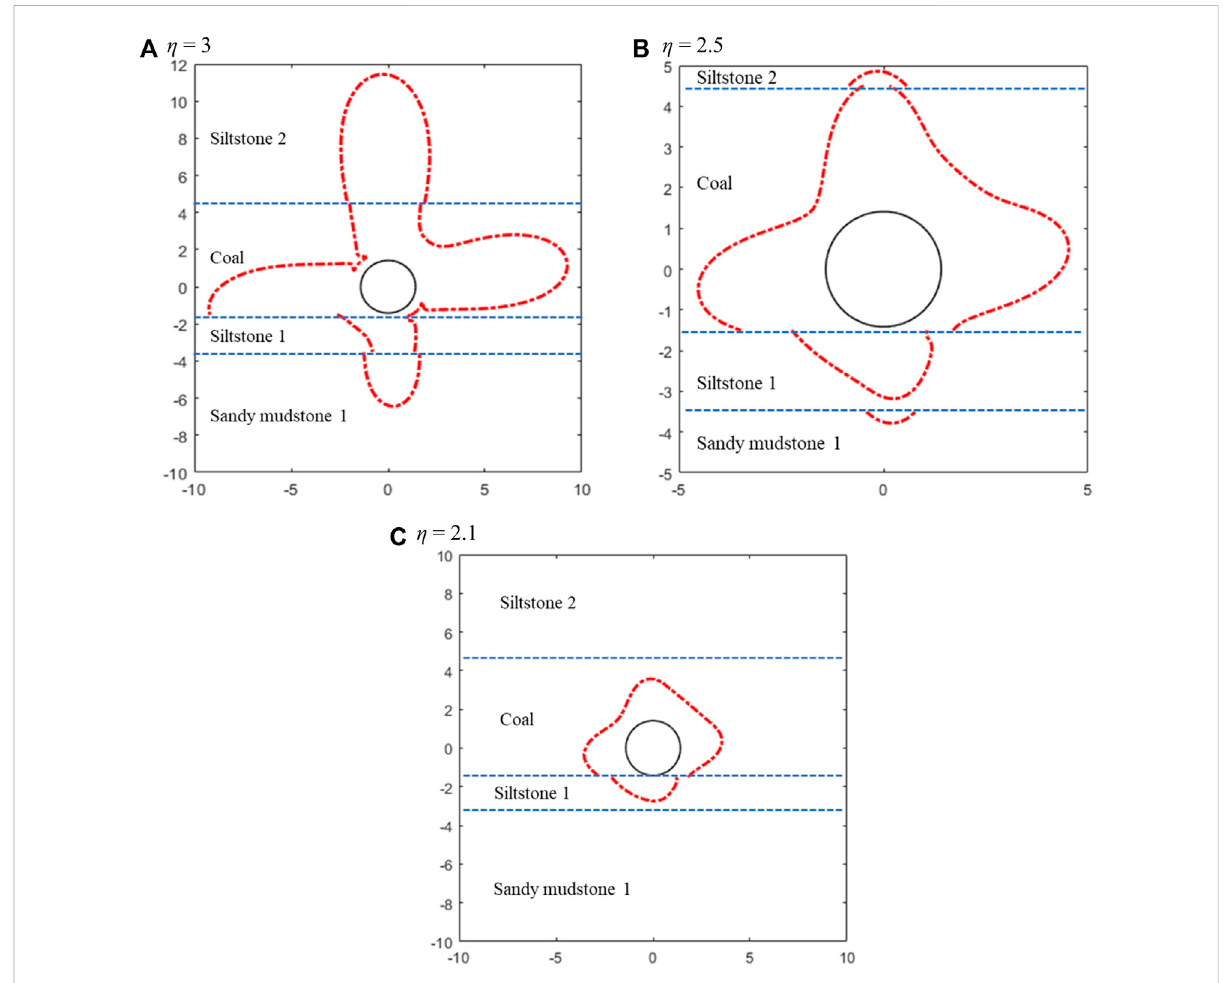
FIGURE 11 In fl uence of the stress ratio on the plastic zone of the surrounding